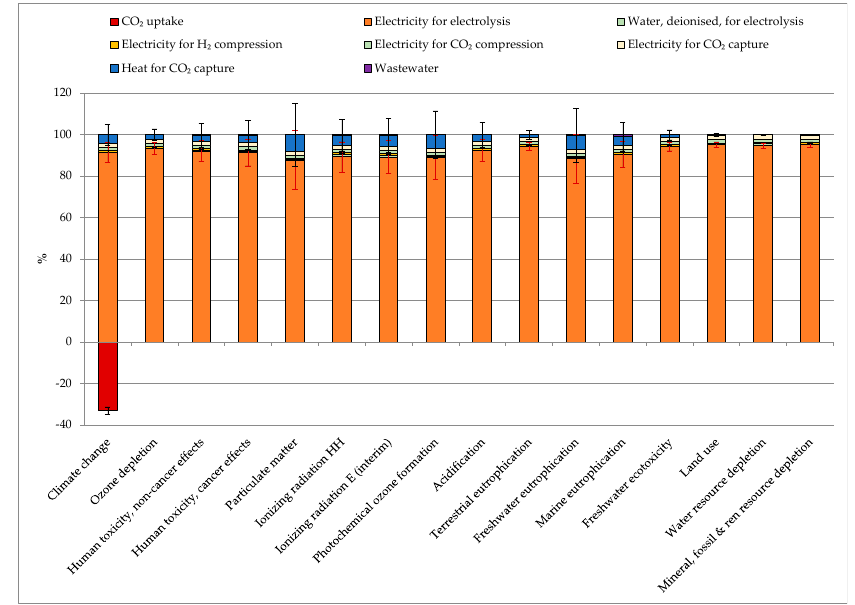
Figure 4. Contribution analysis and impact assessment for the production of 1 kg SNG (Synthetic Natural Gas), average values among all the considered CO 2 sources. The error bars represent the fluctuation depending on the chosen CO 2